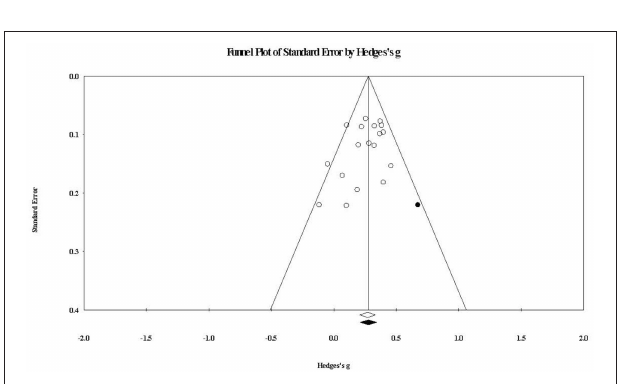
FIGURE 7 | Funnel plot of standard error by within-group overall youth outcomes effect sizes. The black circle represents the effect size of the imputed study that would be required to remove publication bias. The white diamond represents the observed summary effect size, while the black diamond represents the imputed summary effect size free of publication